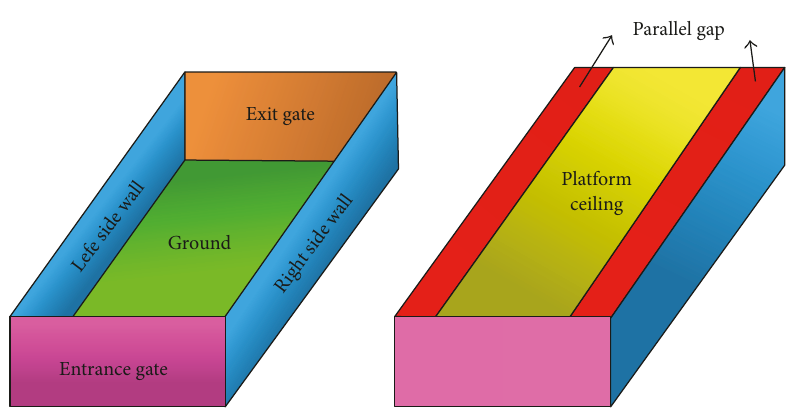
Figure 4: Components of the